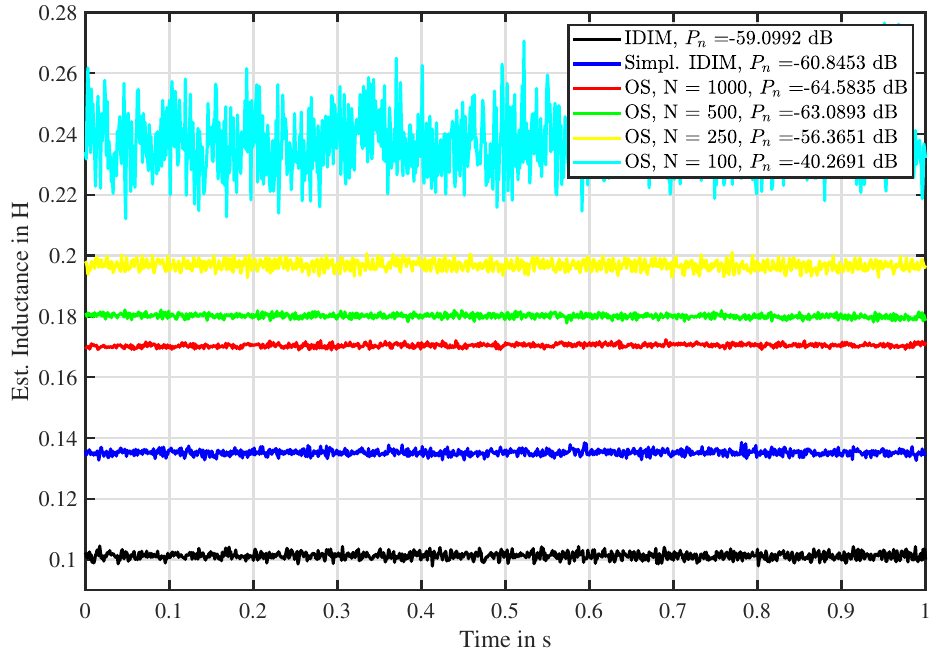
Figure 13. Comparison of the noise power obtained by the different approaches when the actuator is fully closed and full mean current is flowing.